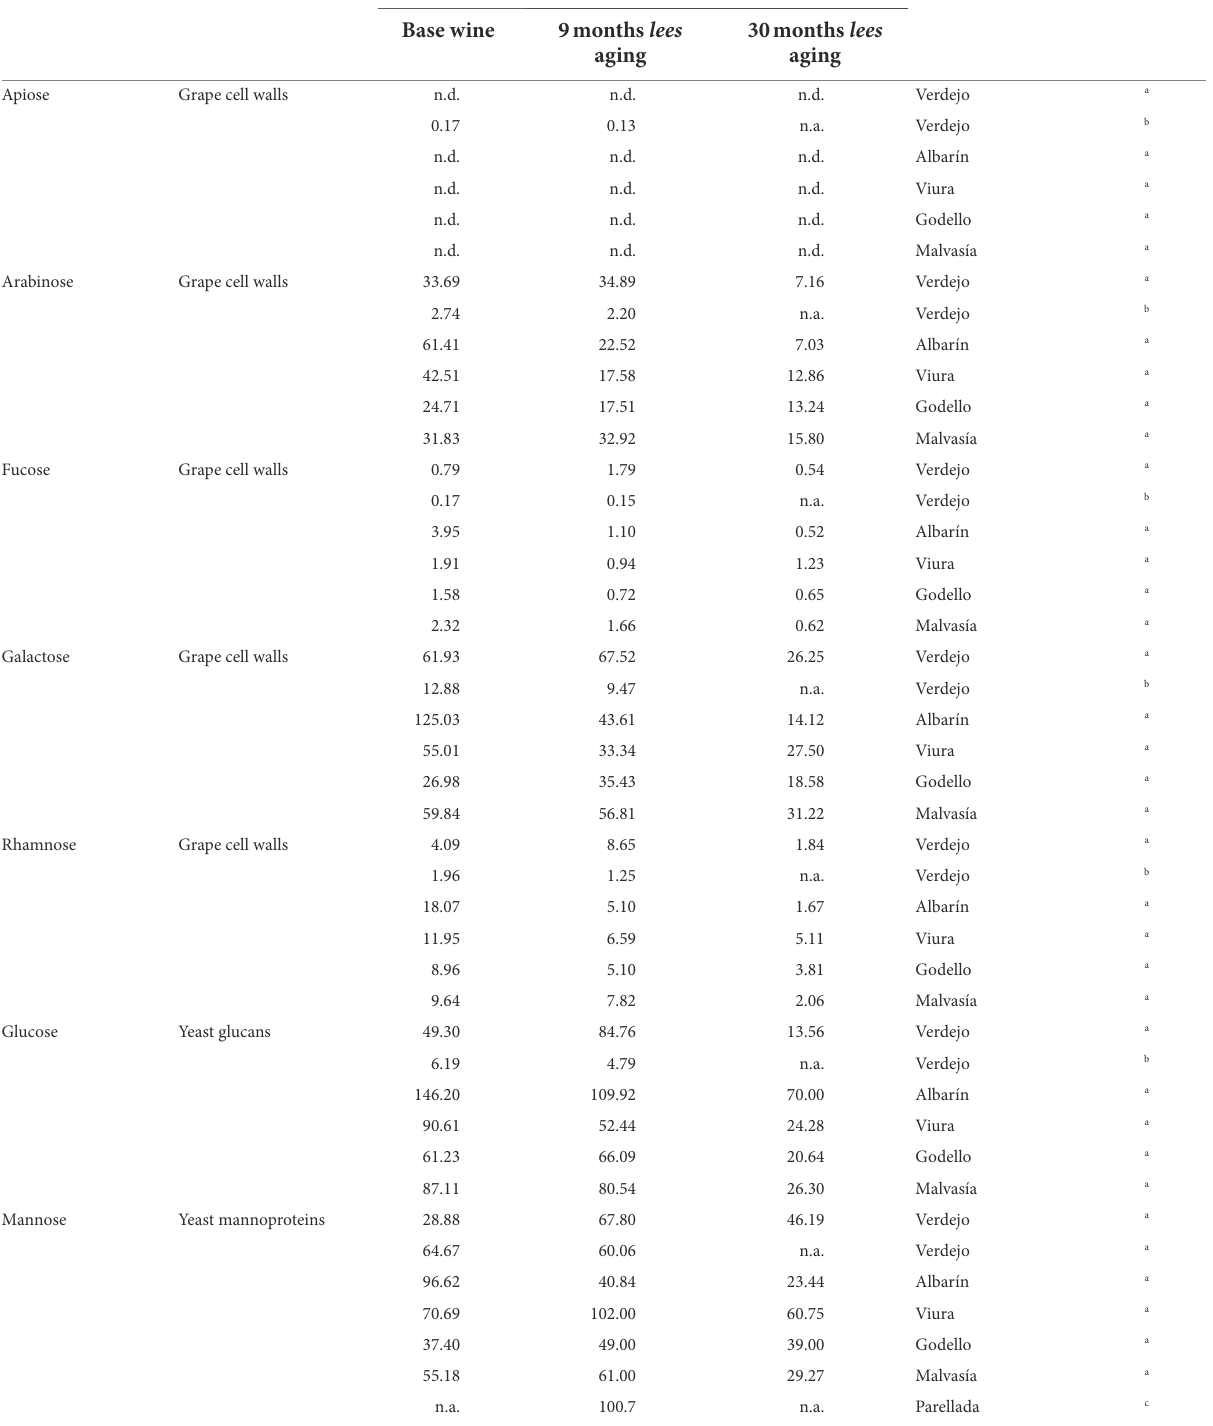
TABLE 1 Mean concentrations (mg/L) of monosaccharides in base wines and traditional method sparkling wines aged on lees for wines produced from Vitis vinifera